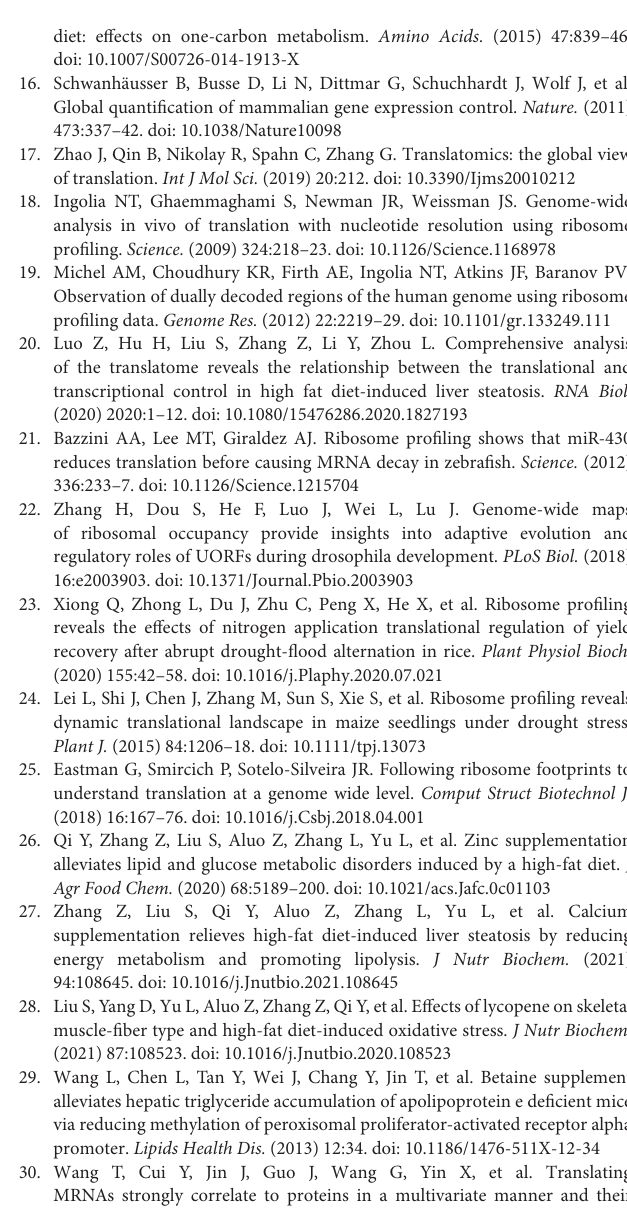
Supplementary Figure 2 | Overview of transcriptome and translatome. (A–D) Distribution of the mRNA and RPFs abundance in M and B groups. (E,F) PCA of RNA-seq and Ribo-seq. (G) Length distribution of RPFs. (H) The percentage of RPFs located in the CDS, 5 ′ UTR, and 3 ′ UTR. Supplementary Figure 3 | Gene expression heatmap of the three up-regulated pathways. Supplementary Figure 4 | Ribo-seq analysis. (A) Venn diagram showing the distinct and overlapping genes of the translatome. (B) Correlation of RPF abundance. (C) NAFLD pathway. Red stands for up-regulated DEGs and green stands for down-regulated DEGs. Supplementary Figure 5 | DTEGs analysis. (A) Volcano plots of DTEGs. (B) TE